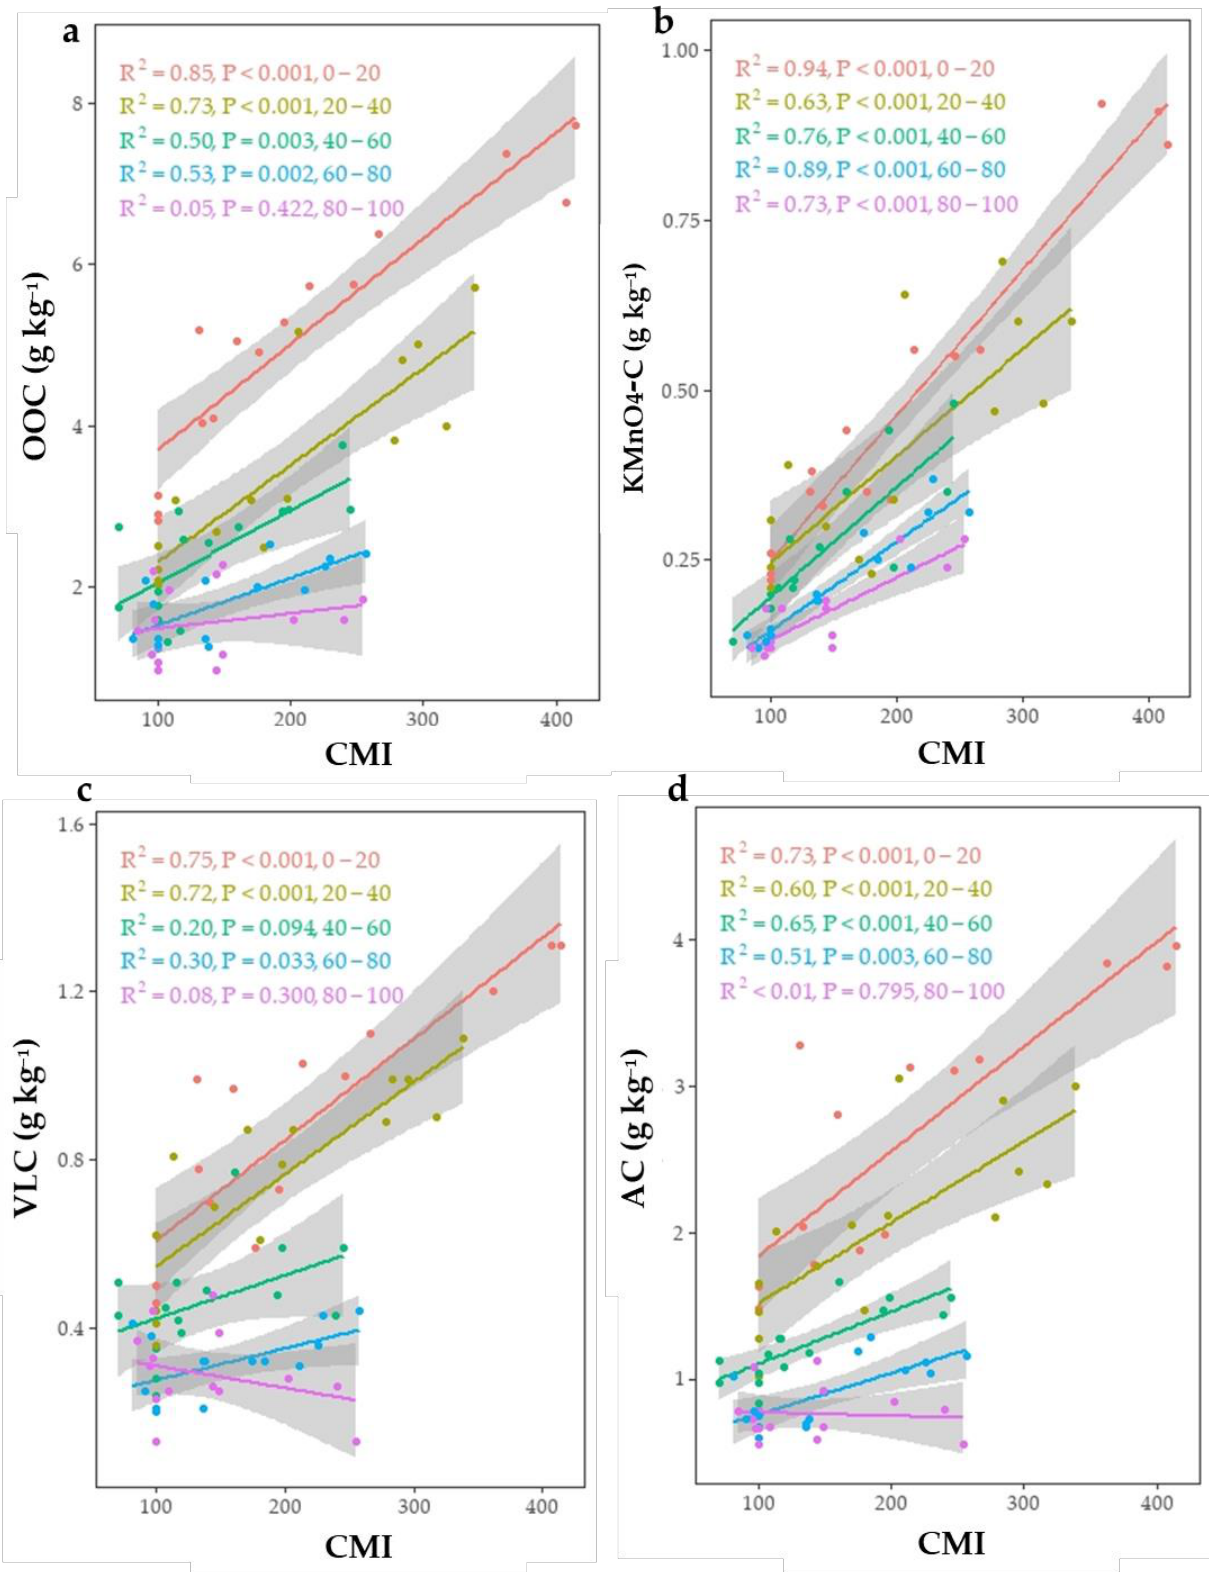
Figure 3. Relationship between carbon management index (CMI) with ( a ) oxidizable organic carbon (OOC), ( b ) KMnO 4 oxidizable organic carbon (KMnO 4 -C), ( c ) very labile carbon (VLC), and ( d ) active carbon (AC) at different soil depths.